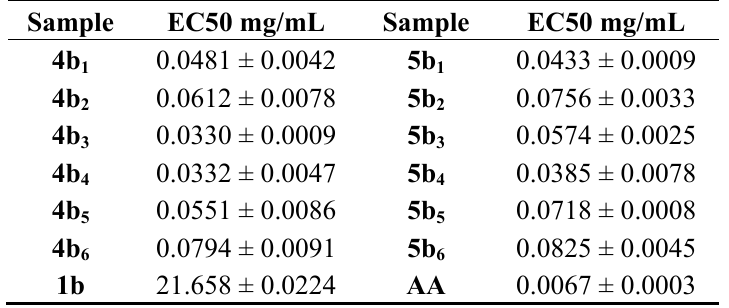
mg/mL) of the sulfisoxazole derivatives 4b 50